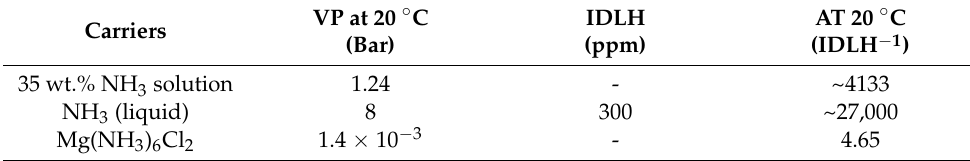
Table 6. Health and Safety data of ammonia and its derivatives [58–60]. VP at 20 ◦ C IDLH AT 20 ◦ C Carriers (Bar) (ppm) (IDLH − 1 ) 35 wt.% NH 3 solution 1.24 - ~4133 NH 3 (liquid) 8 300 ~27,000 Mg(NH 3 ) 6 Cl 2 1.4 × 10 − 3 -